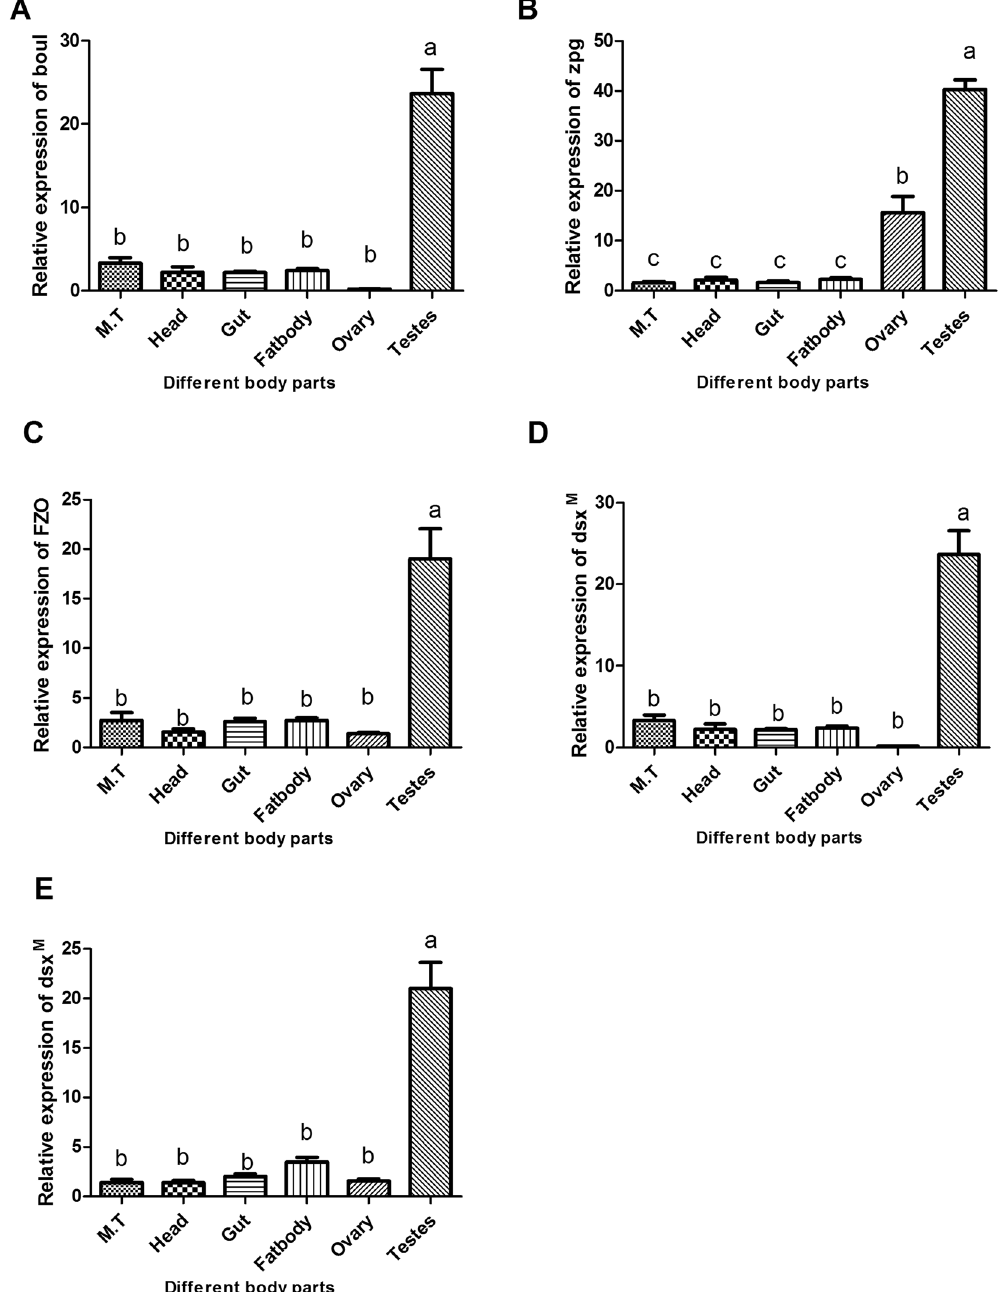
Figure 1. Differential gene expression in various body parts of Bactrocera dorsalis adults including testis, ovary, fat body, gut, head, and malpighian tubules, in response to selective genes ( Boul , Zpg , dsx M , Fzo and Gas8 ). Bars and different letters indicate significant differences in the expression level at p < 0.05 according to Tukey’s